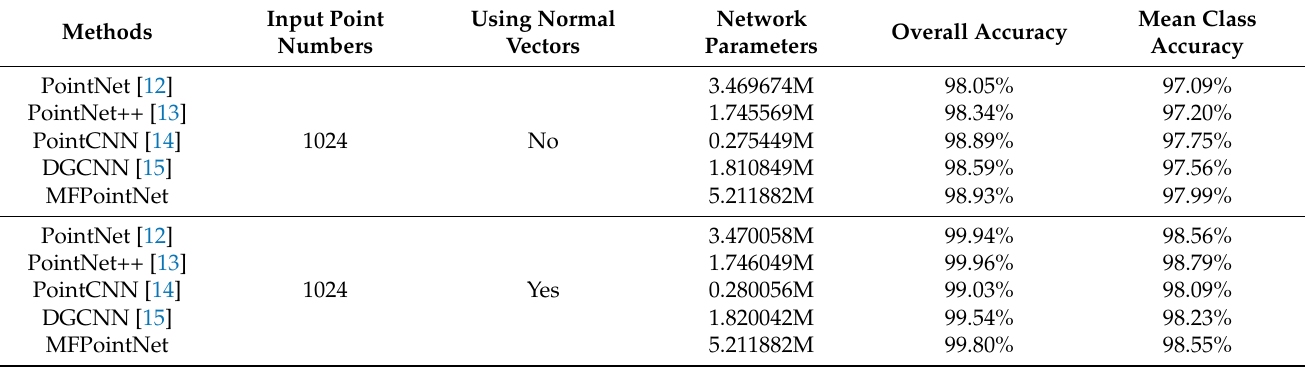
Table 5. The effect of normal vectors on recognition accuracy and network parameters.